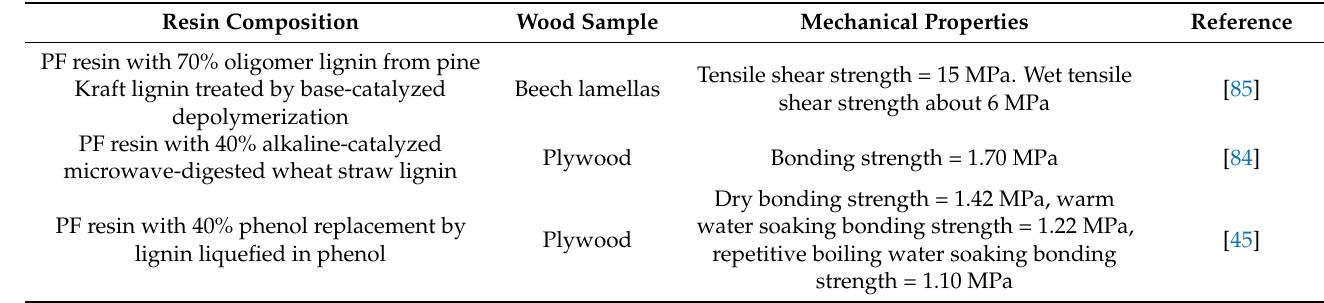
Table 4. Resin composition, sample type, and mechanical properties of selected resins with cleaved lignin described in literature. Resin Composition Wood